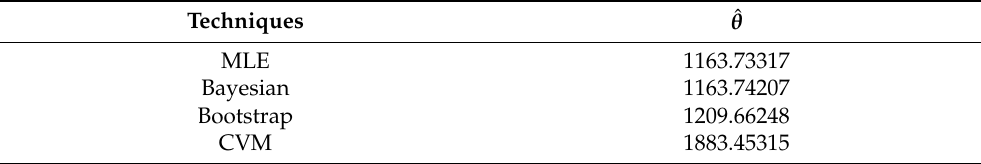
Table 16. The estimated parameters for the IR under insurance-claims